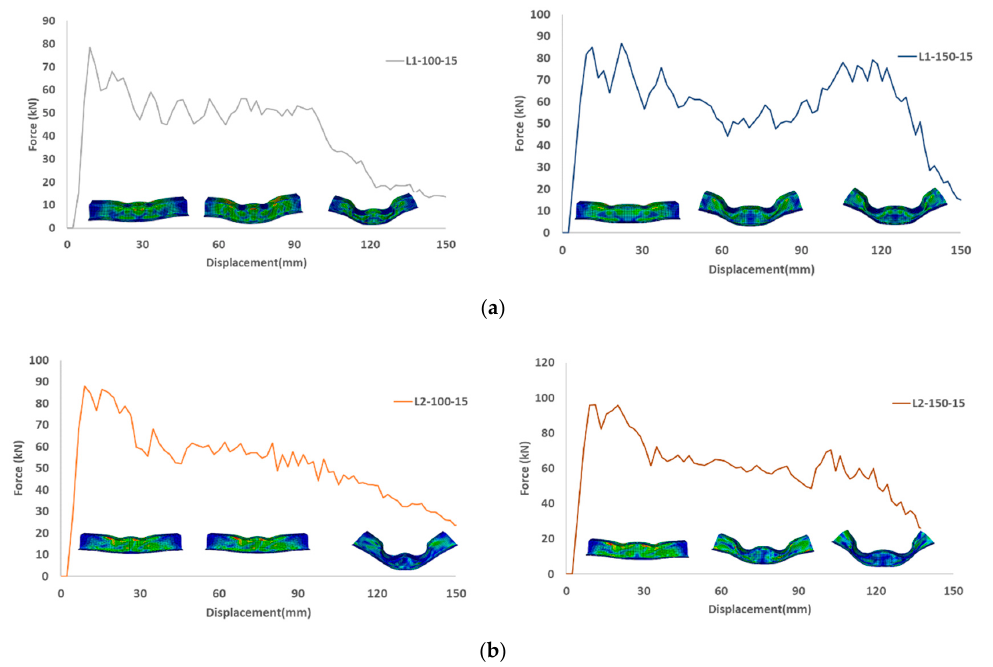
Figure 15. Load displacement diagrams at crushing speed of 15 m/s for different indenter distance of 100 mm and 150 mm ( a ) laminate configuration (0/90/0/90/0/90/0/90) (cid:2870) ( b ) laminate configu- ration (45/−45/90/0/0/90 − 45/45) (cid:2870) .